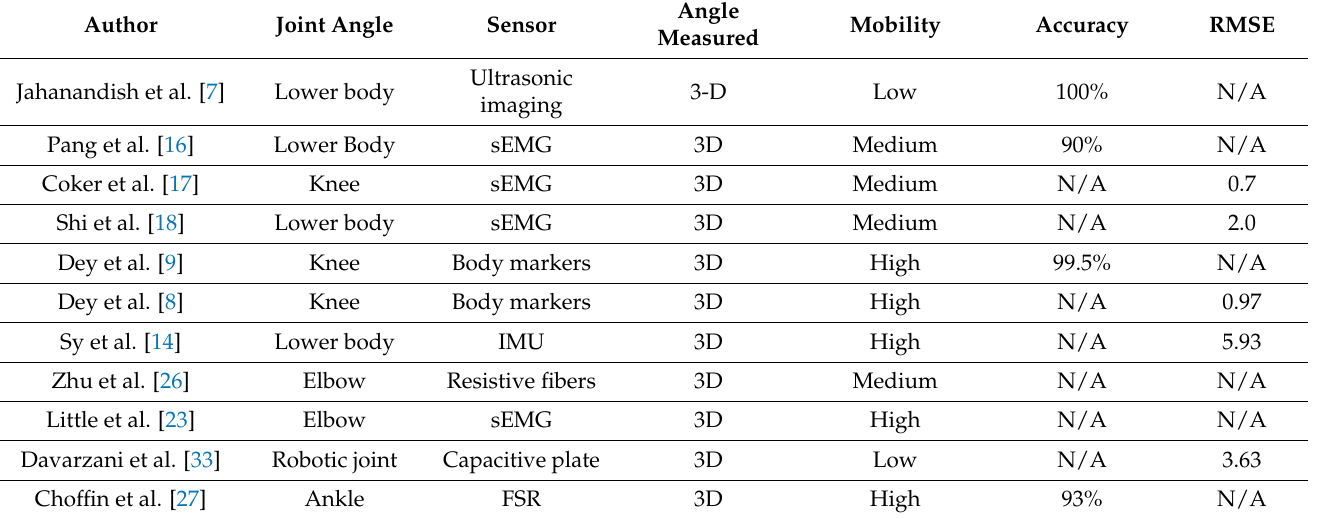
Table 1. Literature review of joint angle detection